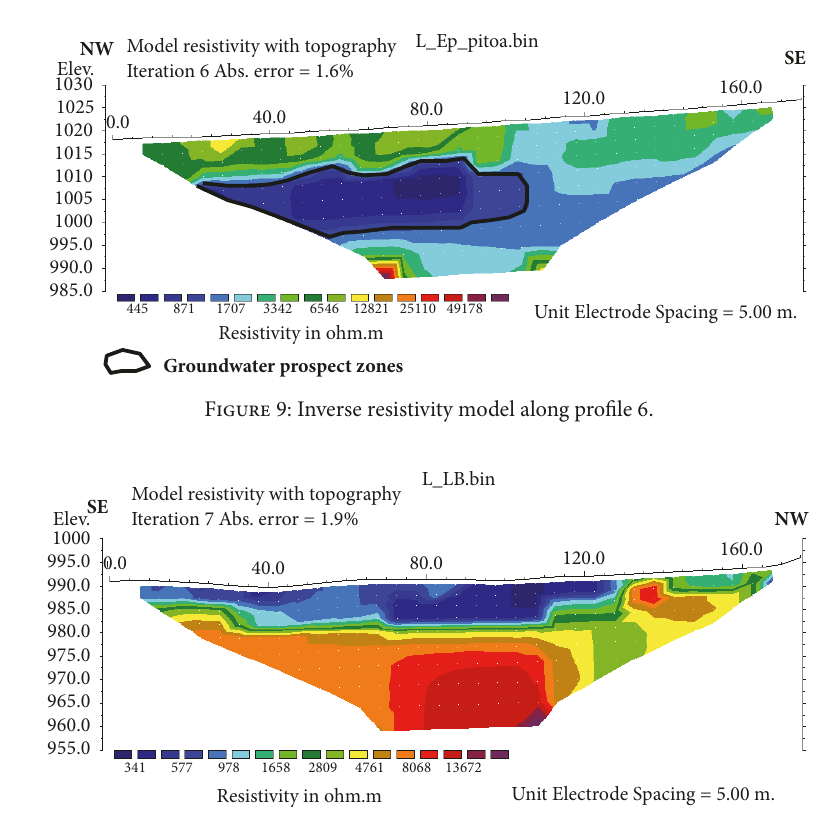
Figure 10: Inverse resistivity model along profile